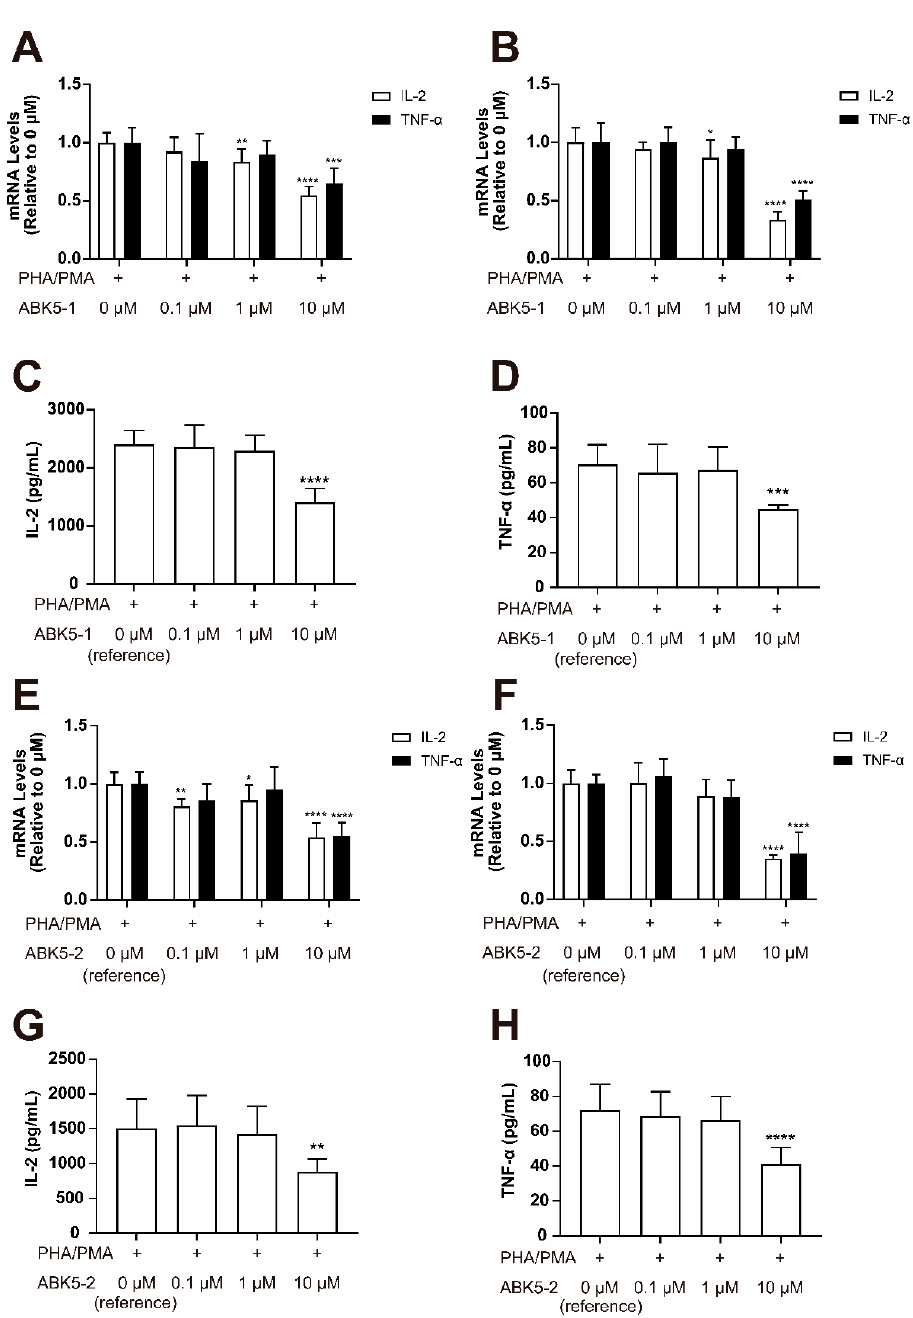
Figure 4. Effect of ABK5-1 and ABK5-2 on phytohemagglutinin (PHA)/phorbol 12-myristate 13- acetate (PMA)-induced cytokine production in T cells. Jurkat cells were pretreated with DMSO (<0.1%; indicated as 0 µ M) or various concentrations of ABK5-1 ( A – D ) or ABK5-2 ( E – H ) and stimulated with PHA and PMA. IL-2 and TNF- α mRNA levels were determined by real-time PCR (RT-PCR) after ABK5-1 treatment and ( A ) 3 h and ( B ) 24 h of PHA/PMA (phytohemagglutinin/phorbol 12-myristate 13-acetate) stimulation. Protein levels of ( C ) IL-2 and ( D ) TNF- α were also examined after 24 h of stimulation. IL-2 and TNF- α mRNA were also examined after ABK5-2 treatment and ( E ) 3 h and ( F ) 24 h of stimulation, and protein levels of ( G ) IL-2 and ( H ) TNF- α were measured after 24 h stimulation. Results are indicated as the mean ± S.D. of three independent assays per- formed in triplicate for each concentration. One-way ANOVA and Dunnett’s post-hoc test were used and * p < 0.05, ** p < 0.01, *** p < 0.005, **** p < 0.0001 (versus reference).